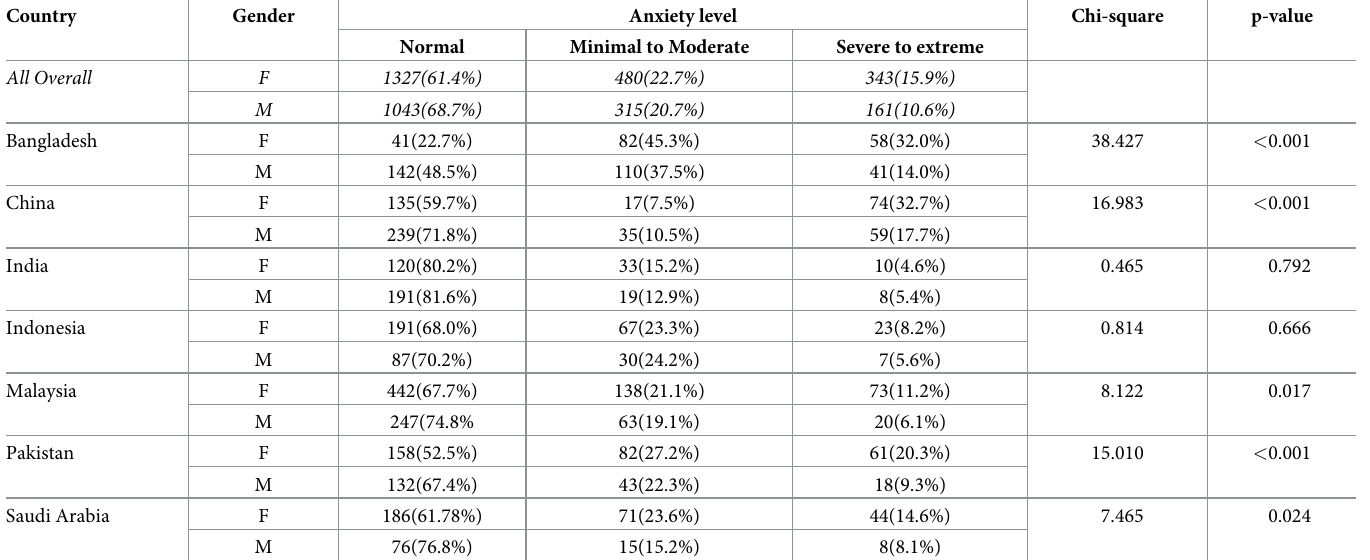
Table 3. Level of anxiety between male and female students by country.